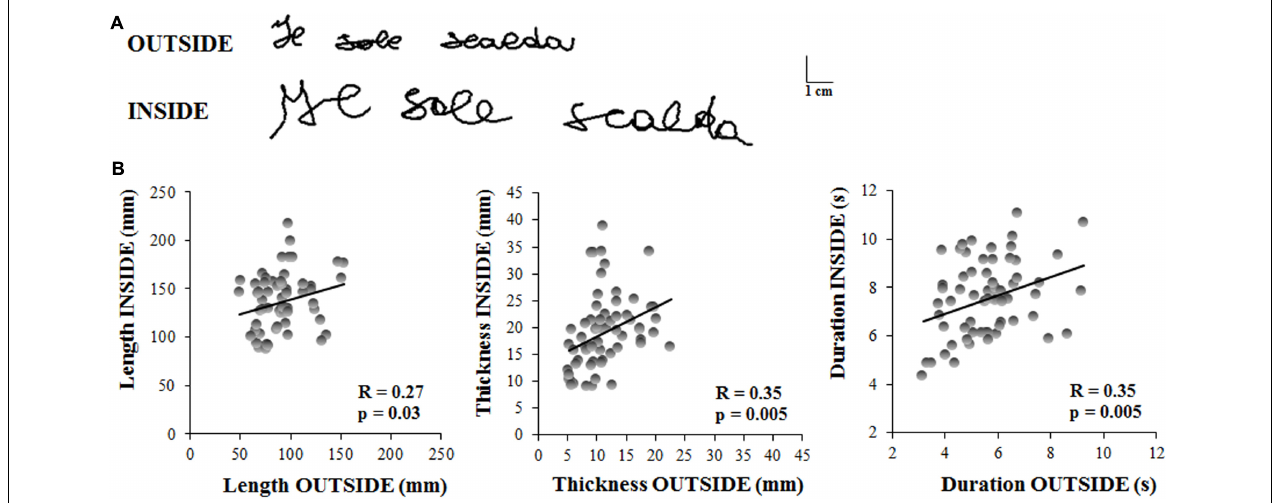
FIGURE 3 | Experiment 2. (A) Written traces of one representative participant acquired outside and inside the magnetic resonance environment. (B) These graphs show the linear regression models that describe the relationship between the kinematic parameters of the sentences written by the subjects outside and inside the MR scanner. Each dot refer to a single sentence written by a participant. Each participant wrote three sentences in each condition. Pearson’s coefficient (R) and the related level of significance (p) are reported in each graph.